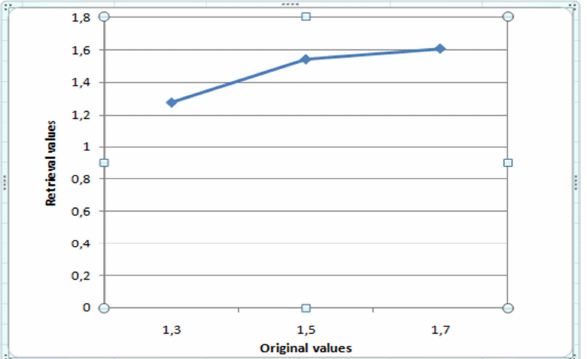
Figure 15. The retrieving soil moisture parameter eeee 1 after the inversion by the NN function of its original value